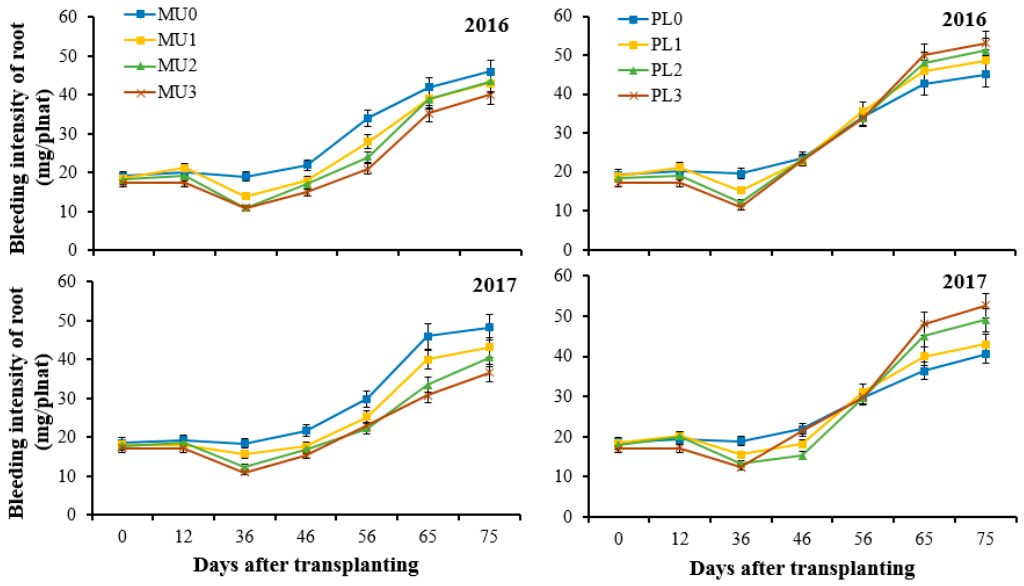
Figure 6. Dynamic changing of the bleeding intensity of rice roots under different straw incorporation treatments. MU 0 , MU 1 , MU 2 , and MU 3 represent 0.0 t/hm 2 , 1.5 t/hm 2 , 3.0 t/hm 2 , and 4.5 t/hm 2 of straw, respectively, which were incorporated in the soil by a mulching method. Whereas PL 0 , PL 1 , PL 2 , and PL 3 represent 0.0 t/hm 2 , 1.5 t/hm 2 , 3.0 t/hm 2 , and 4.5 t/hm 2 of straw, respectively, which were incorporated in the soil by a plowing method.